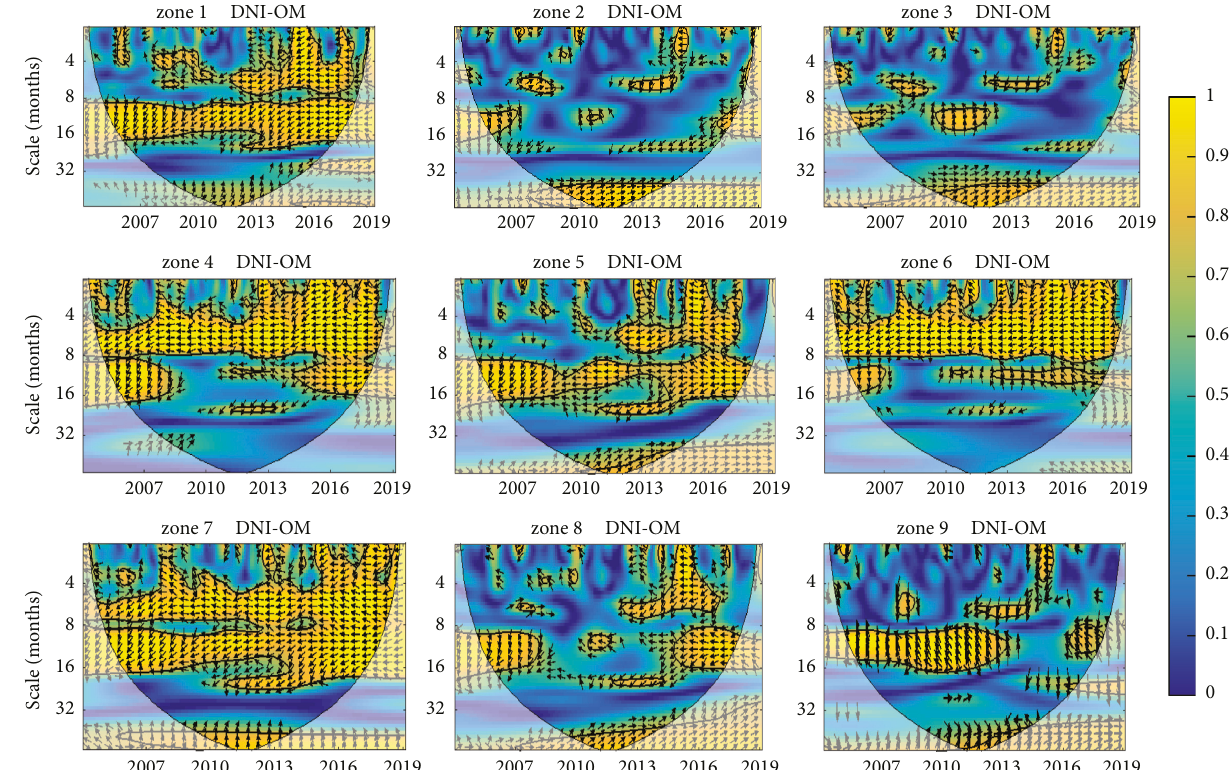
Figure 9: Wavelet coherence between the monthly average of DNI and OM time series (2005–2019). Areas of statistical significance are circled in black; the area outside the cone of influence has no statistical significance. The relative phase dependence is indicated by arrows (antiphase as oriented toward the left, and DNI in advance of phase to OM as arrows pointed